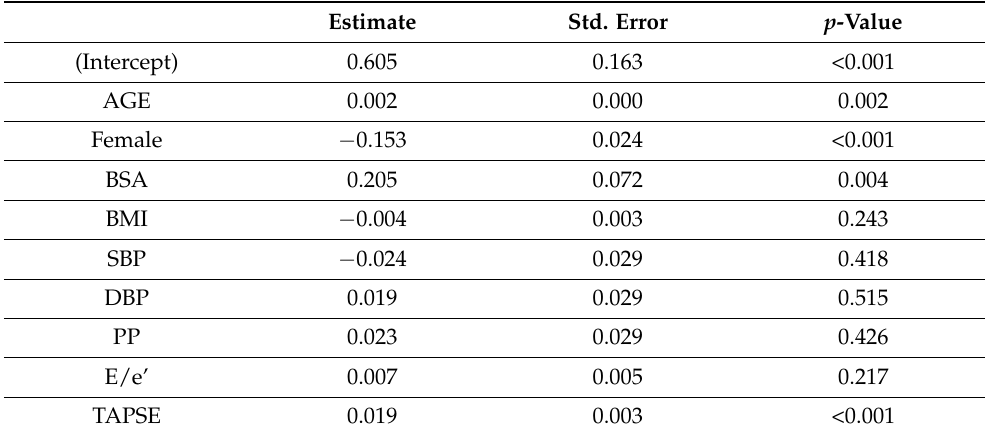
Table 6. Multivariate analysis of the MEEi values. Estimate Std. Error p -Value (Intercept) 0.605 0.163